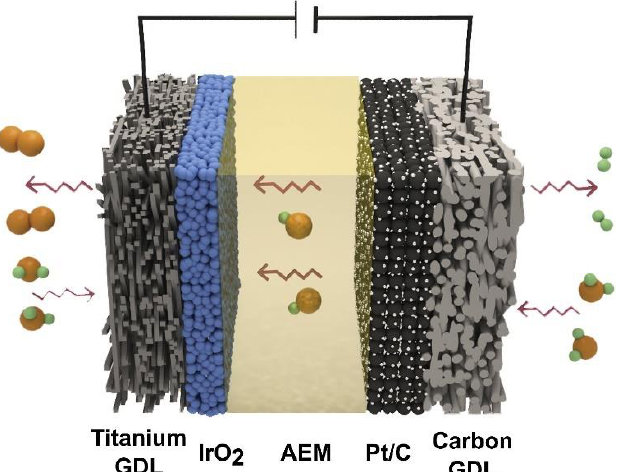
Figure 8. Single-cell components in AEM water electrolysis. Reproduced with permission from [107]. The half-cell reaction at the anode in an AEM electrolysis is shown in Equation (10):